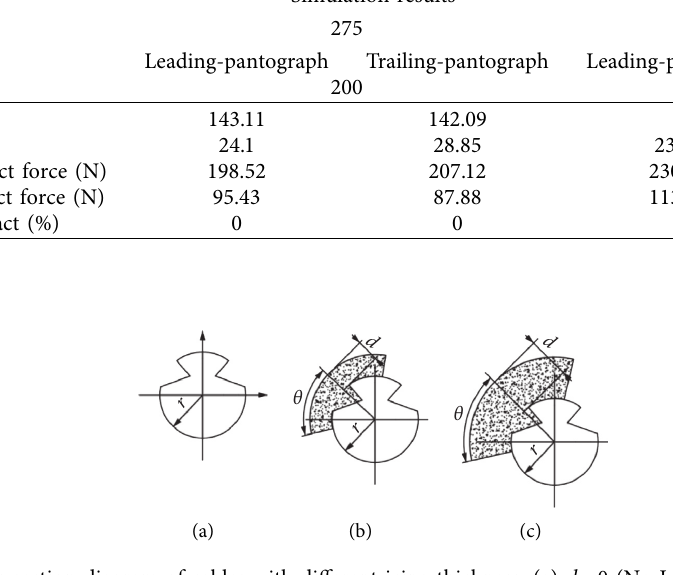
Figure 4: Cross section diagram of cables with different icing thickness. (a) d � 0 (No Ice). (b) d � r /2. (c) d � r .